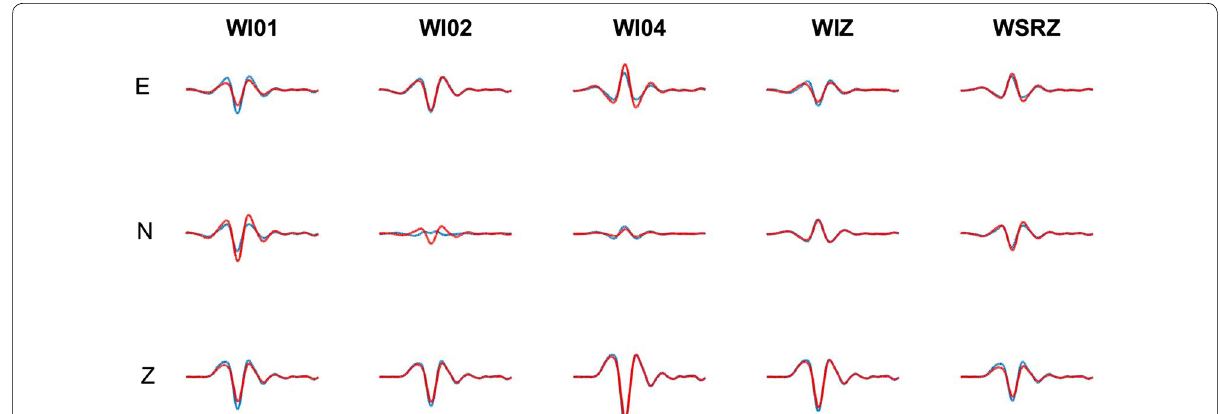
Fig. 8 Velocity waveform fit ( R 0.07). Note that N component of velocity at WI02 station has different shape to other waveforms. A possible reason = is the tilt dominating the ground motion at this station/component, even at this narrow frequency band (0.03–0.1